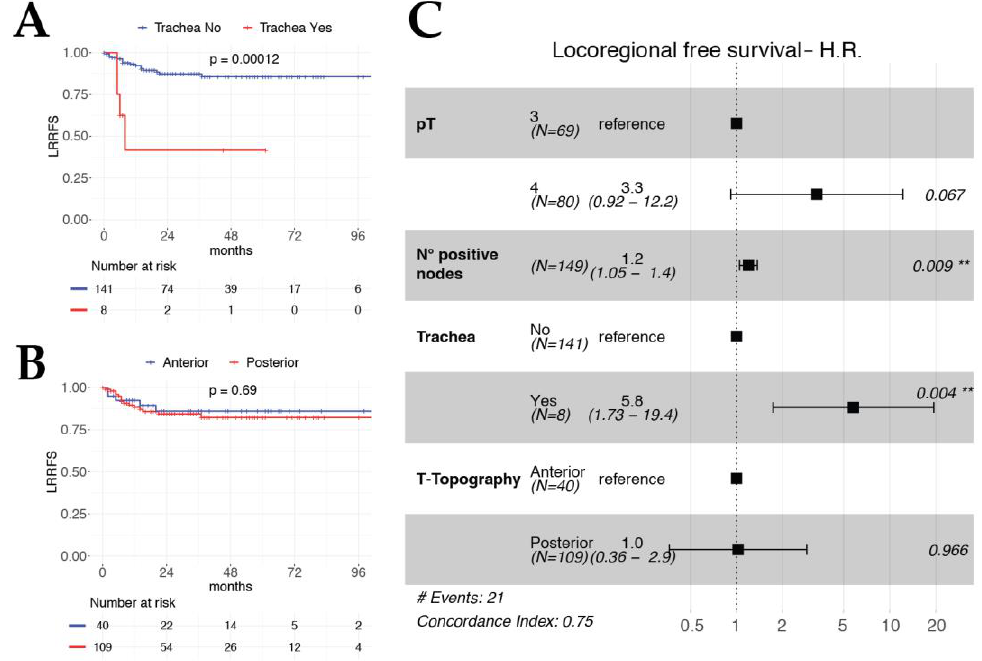
Figure 4. Kaplan–Meier curves for LRRFS according to the tracheal involvement ( A ) and T-topography ( B ). Forest plot of LRRFS multivariable model ( C ).